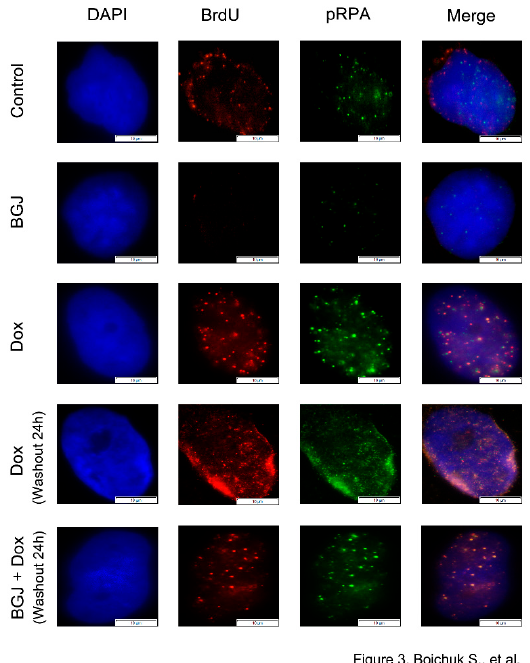
Figure 3. Inhibition of FGF-signaling has no impact on the processing of double-strand breaks (DSBs) and RPA loading. GIST T-1R cells were labeled with 10 μ g/mL BrdU for 4 h prior to DNA damage (0.25 μ g/mL doxorubicin for 4 h) following washout for 24 h in absence and presence of BGJ398 (1 μ M), a selective FGFR1-4 inhibitor. Immunofluorescent detection of incorporated BrdU without denaturation and phosphor-RPA was performed. DAPI staining was used to outline the nucleus. (Scale bars = 10 μ m).